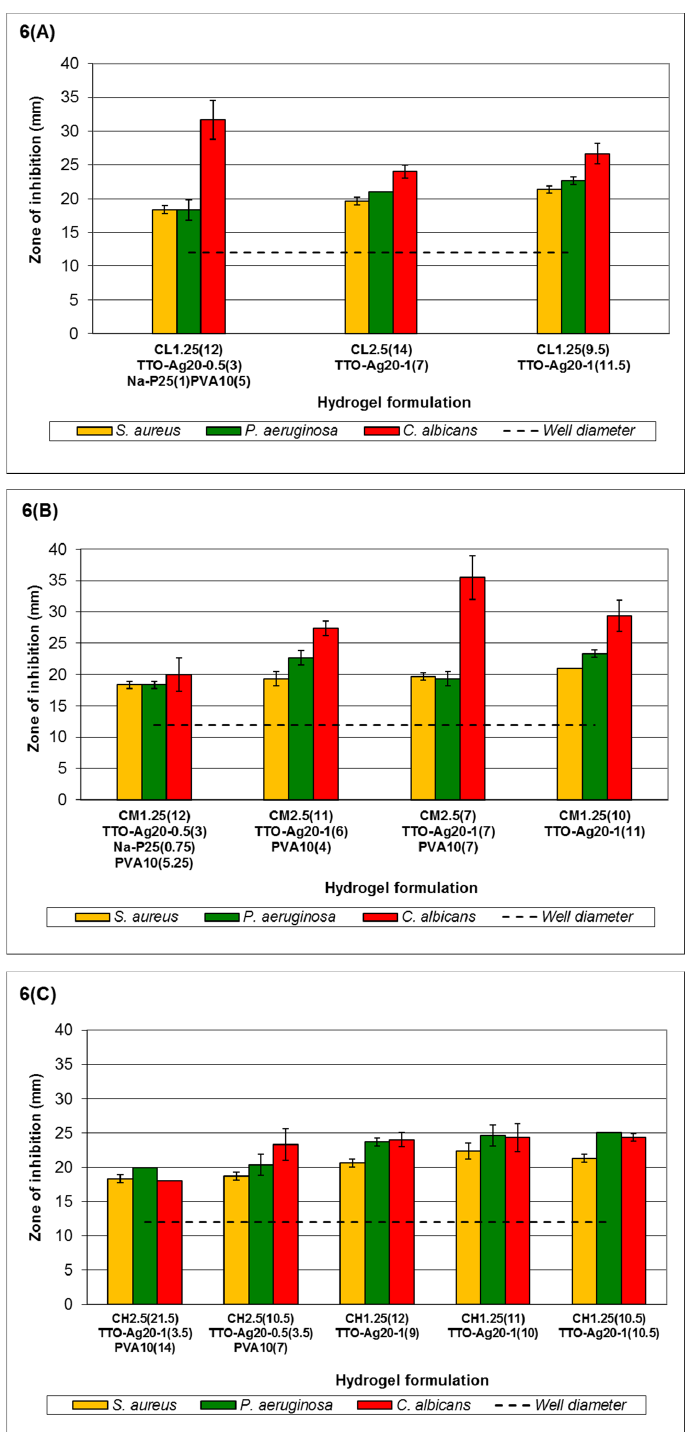
Figure 6. Antimicrobial activity of Ag + + TTO: PVA hydrogels formulated with ( A ) low-viscosity chitosan; ( B ) medium-viscosity chitosan; and ( C ) high-viscosity chitosan. Error bars represent the standard deviation and n = 3. In all control experiments (using hydrogels without Ag + + TTO: PVA),